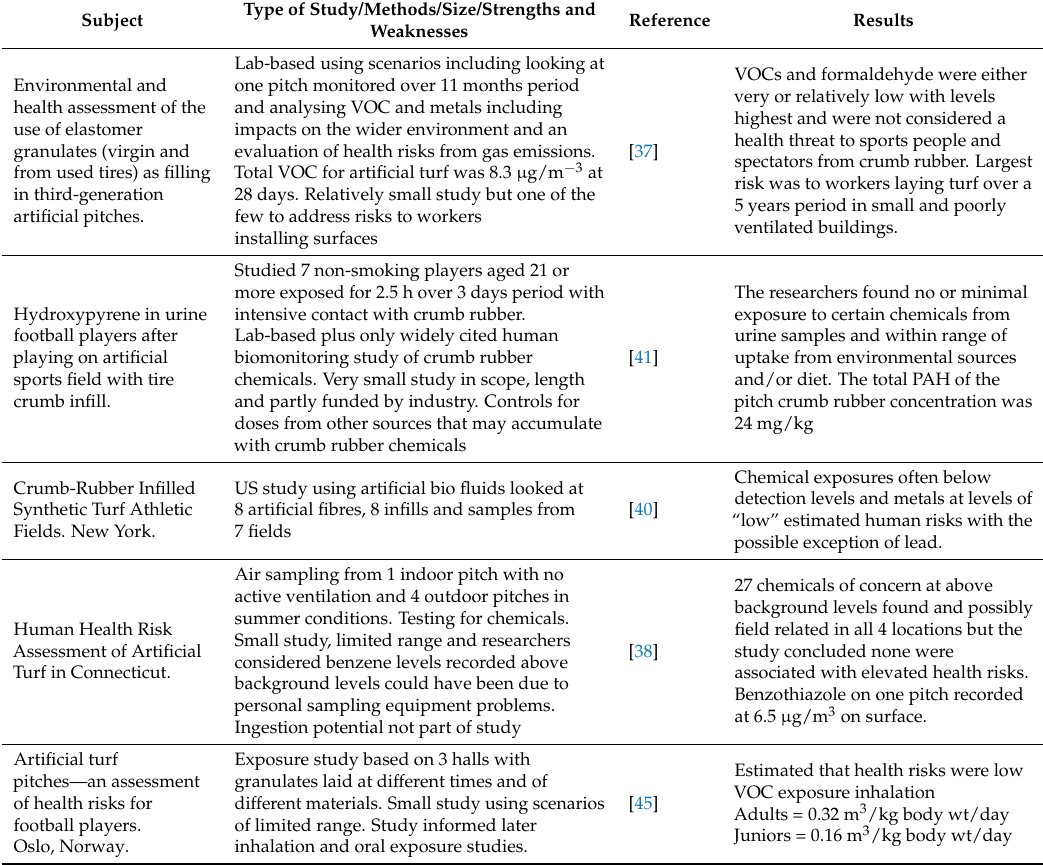
Table 1. Some key studies from the scientific literature indicating little potential risk from crumb rubber on 3G pitches and playgrounds for most but not all exposed groups and excluding